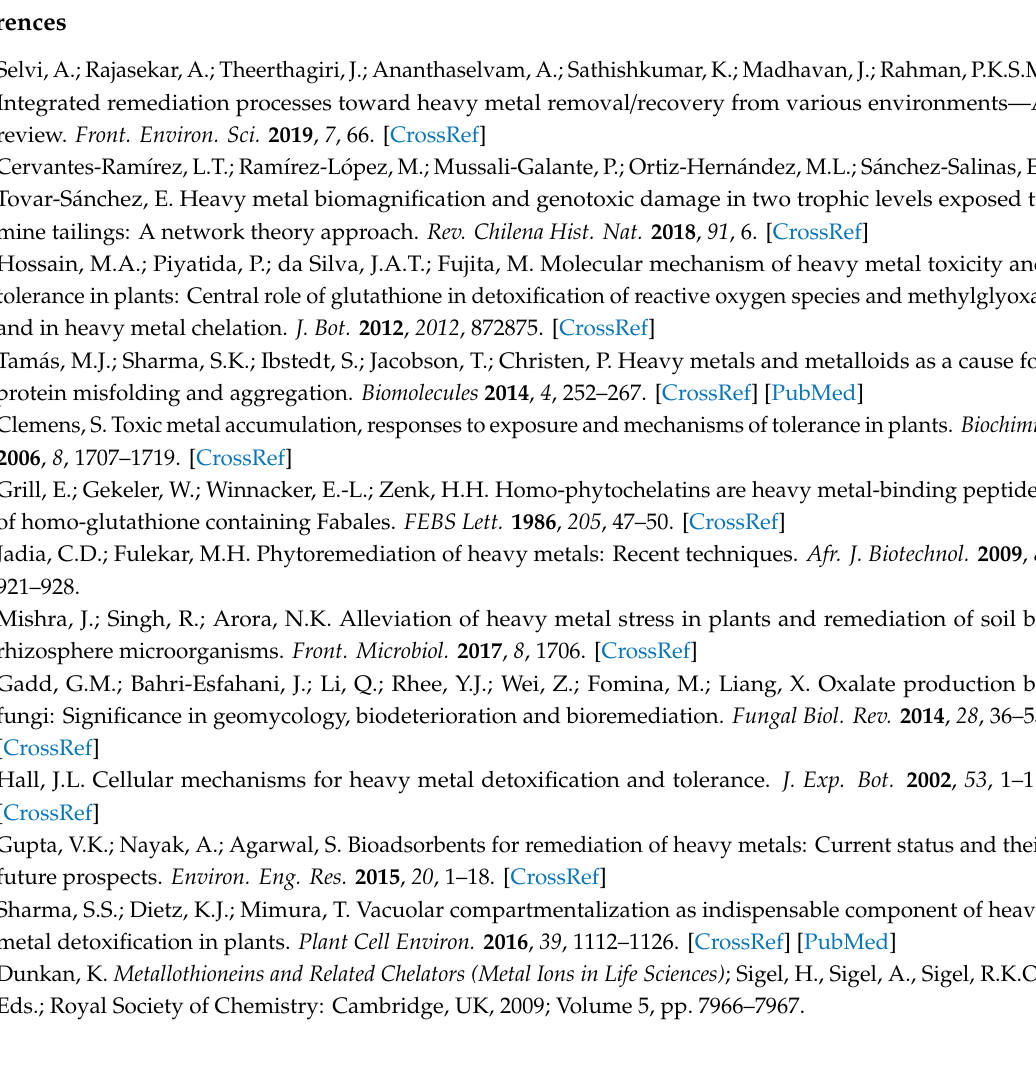
Figure S1: Morphotypes of fungi isolated from V. farnesiana. Table S1: Combination of heavy metals in ppm for di ff erent treatments for strains H17 and H21; Table S2: HPLC gradient method for the detection of organic acids roots; Figure S2: TEAC-DPPH analysis of antioxidant activity. (a) Standard curve of Trolox. (b) Fungal extracts tested in DPPH assay. Figure S3. Specimens of V. farnesiana growing at the site of collection in the Huautla’s mine